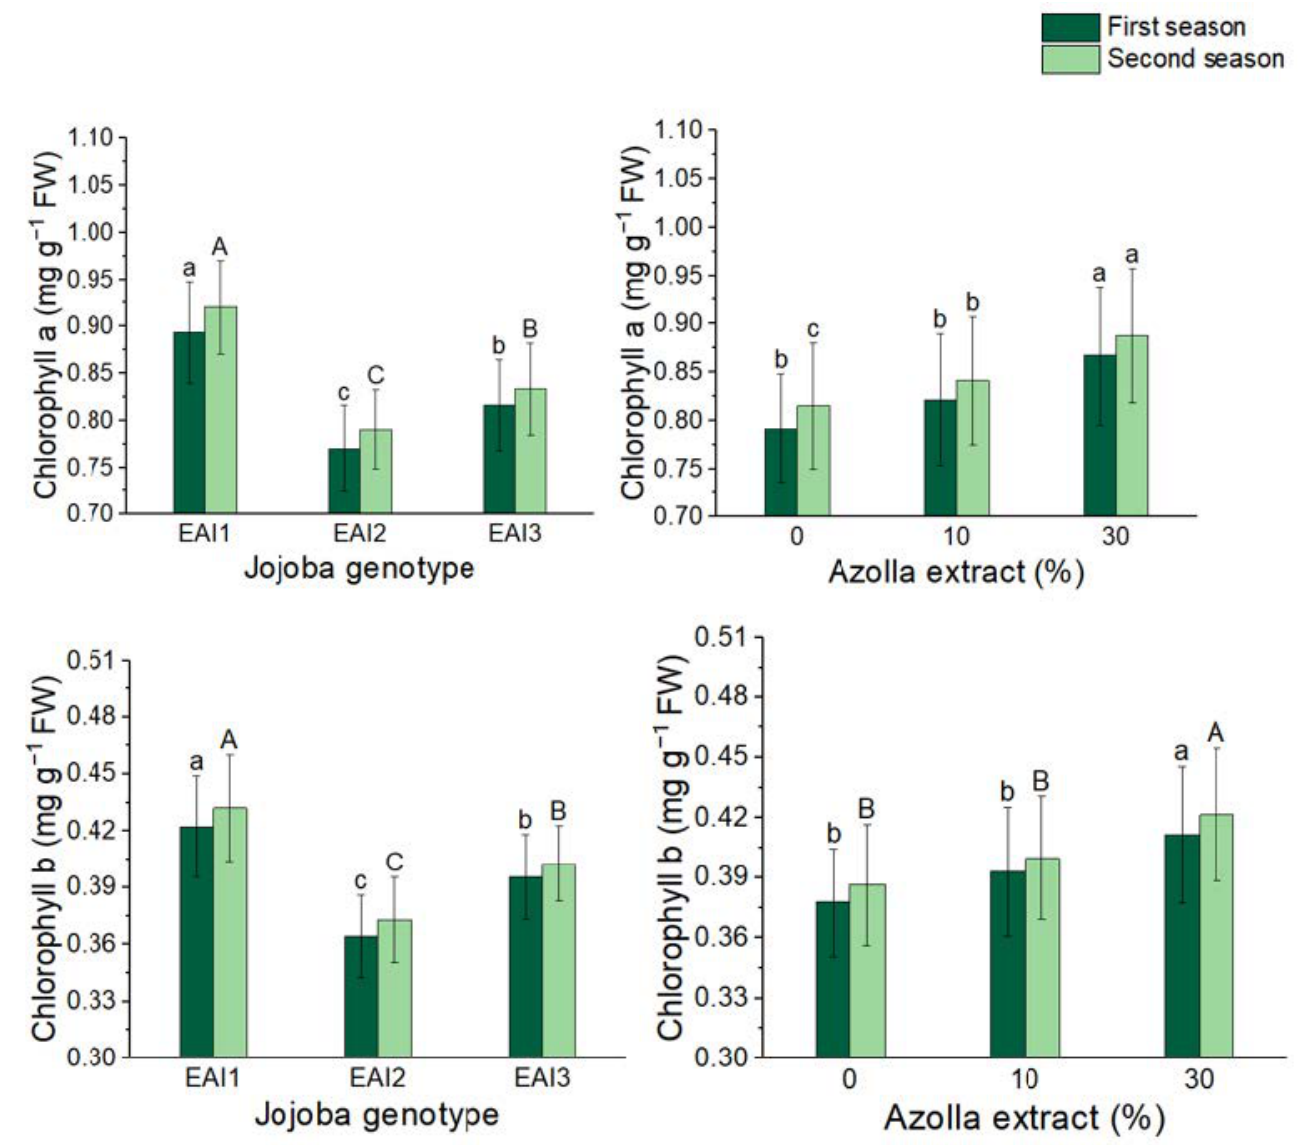
Figure 6. In both seasons, the mean values of chlorophyll a and b (mg g − 1 FW) of jojoba shrubs were modified by plant genotypes and foliar application of Azolla filiculoides Lam. plant extract respectively. The data are expressed as a mean value ± SE. at the 0.05 level, bars with identical letters are not significant. Table 7. In both seasons of the study, the mean values of chlorophyll a and b (mg g − 1 FW) of jojoba shrubs as influenced by combined treatments of plant genotypes and foliar application of Azolla filiculoides Lam. plant